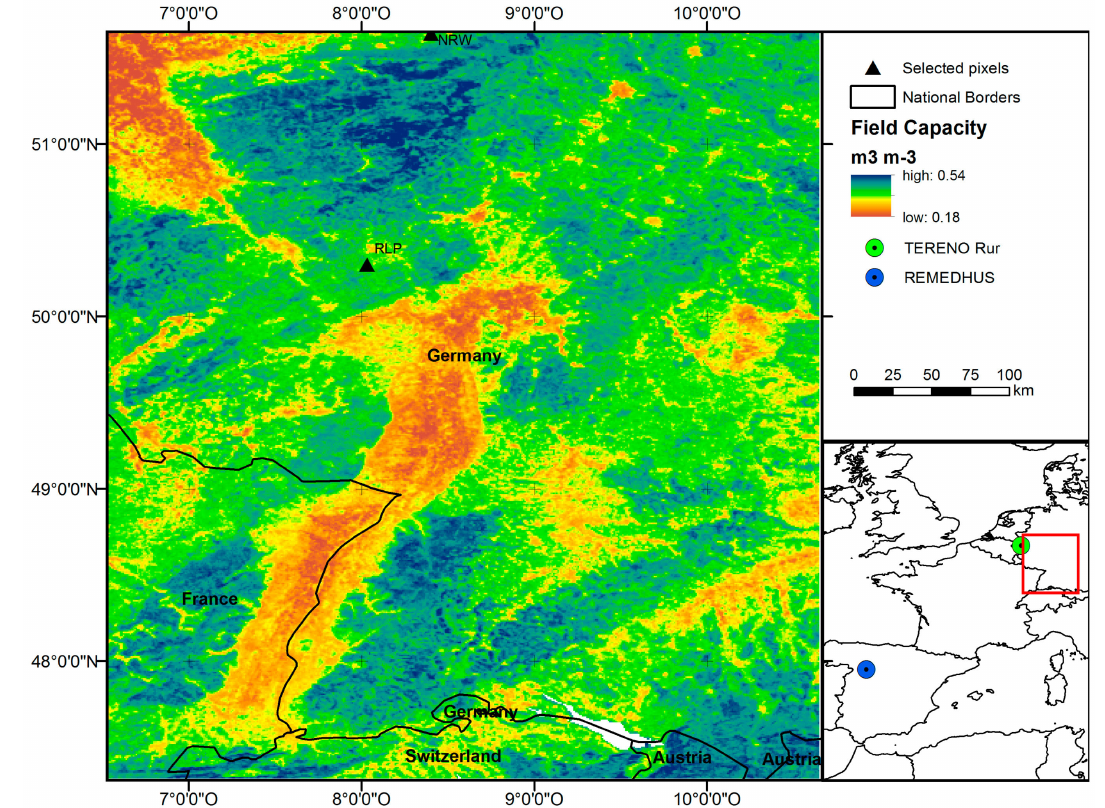
Figure 5. Field capacity of the Upper Rhine valley region calculated from SoilGrids to be used as a proxy for downscaling. Selected grid points NRW and RLP indicate the German focus center pixels discussed in Section 3.1. Soil moisture monitoring networks in the TERENO Rur catchment in Germany and in the REMEDHUS region in Spain are used for